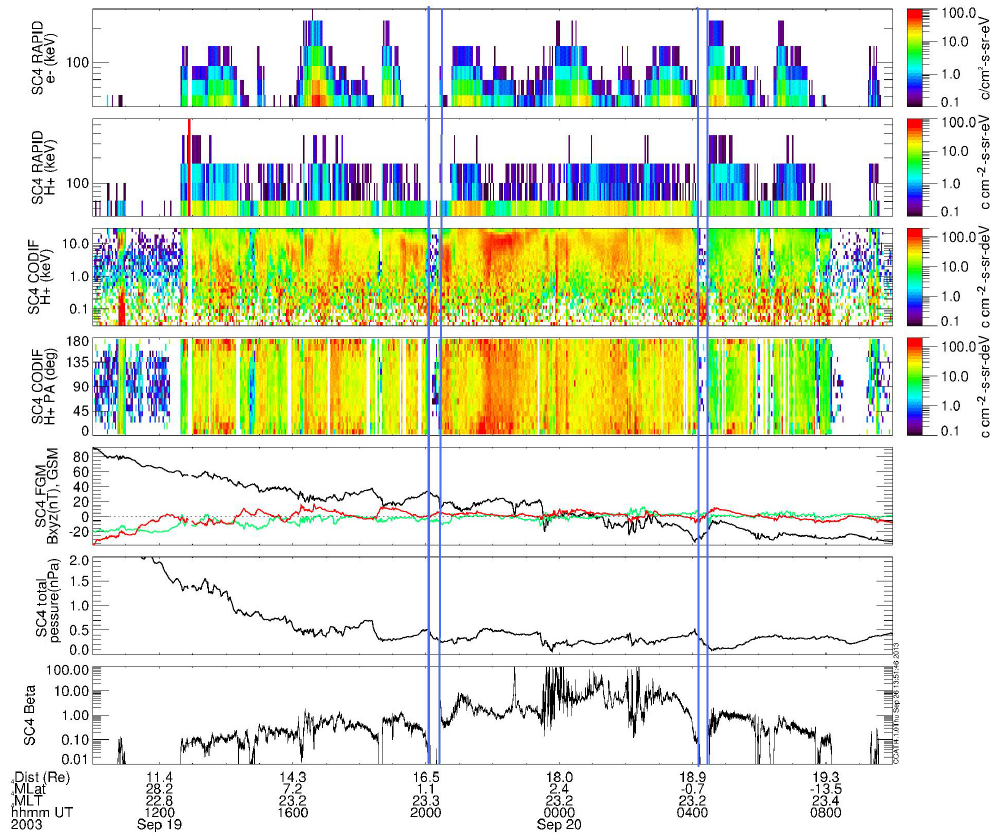
Figure 3. Cluster C4 spacecraft data for the tail crossing T2 (10:00UT, 19 September 2003 to 10:00UT, 20 September 2003). Panels are Cluster C4 RAPID electron energy spectrum, RAPID H + energy spectrum, CODIF H + energy spectrum, CODIF H + pitch angle spectrum, FGM magnetic field components ( x , black line; y , green line; z , red line) in GSM coordinates, CODIF total pressure and CODIF plasma